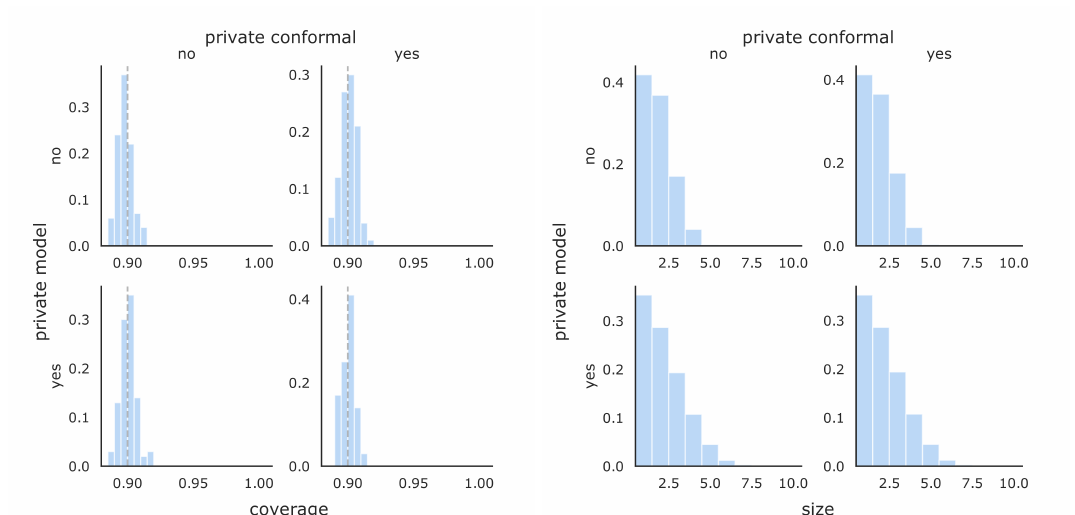
Figure 4: Coverage and set size with private/nonprivate models and private/nonprivate con- formal prediction. We demonstrate histograms of coverage and set size of nonprivate/private models and nonprivate/private conformal prediction at the level α = 0 . 1, with ϵ = 8, δ = 1 e − 5, and n = 5000.